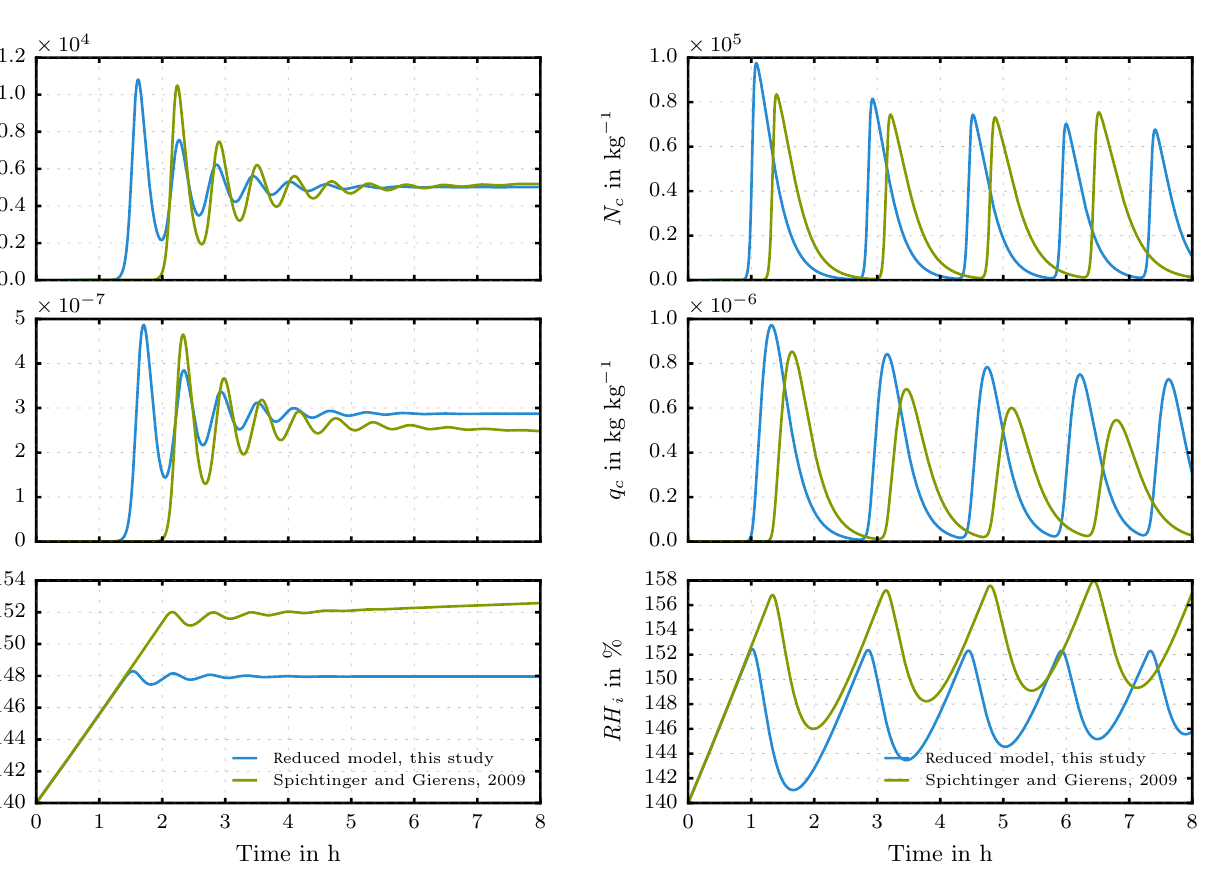
Figure 13. Stable focus case (state 1): comparison between reduced model (this study) and the complex box model by Spichtinger and Gierens (2009). Updraught w = 0 . 01ms − 1 , temperature in the re- duced model and start temperature of the complex model is T = 220K.